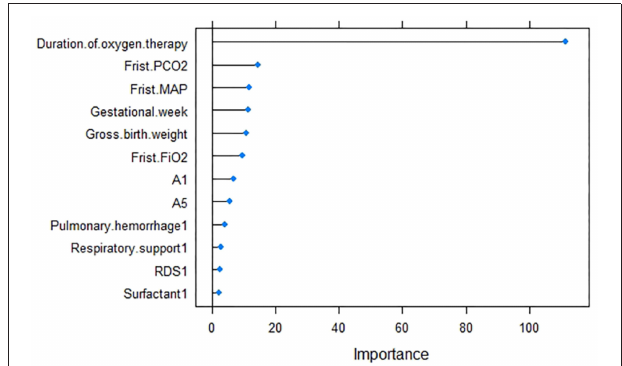
FIGURE 3 | Model 1 variable importance.